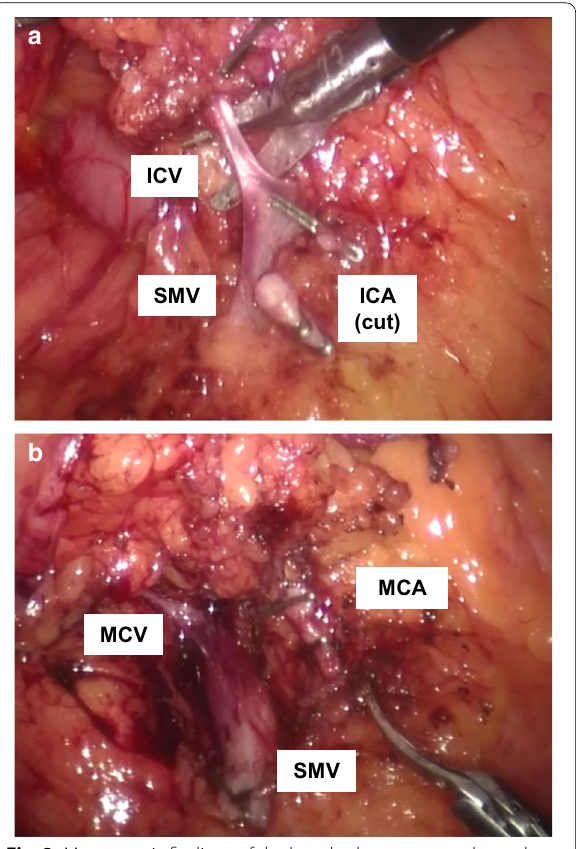
Fig. 2 Macroscopic findings of the lymphadenectomy and vessels. a A photograph shows the root of the ileocolic vein (ICV) that joins the superior mesenteric vein (SMV) after lymphadenectomy. b A photograph shows the origin and root of the middle colic artery (MCA) after